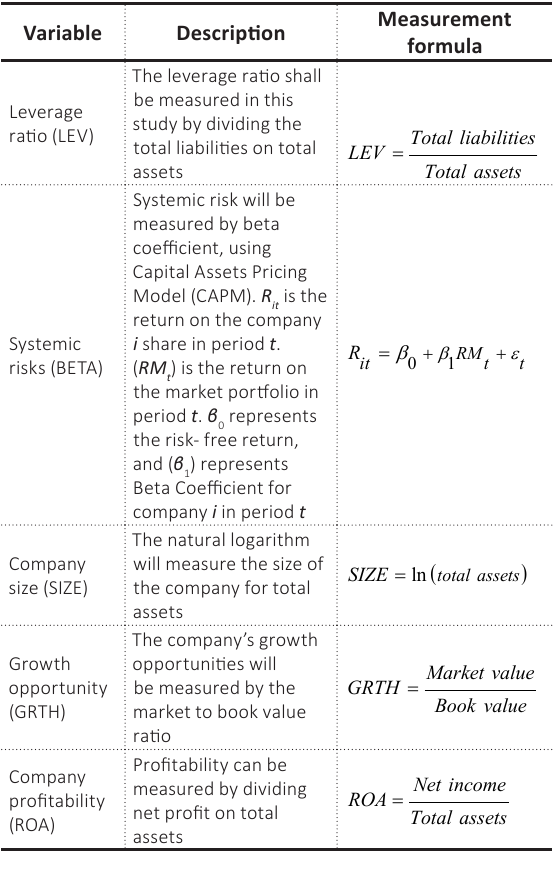
Table 1. Summary of the study dependent